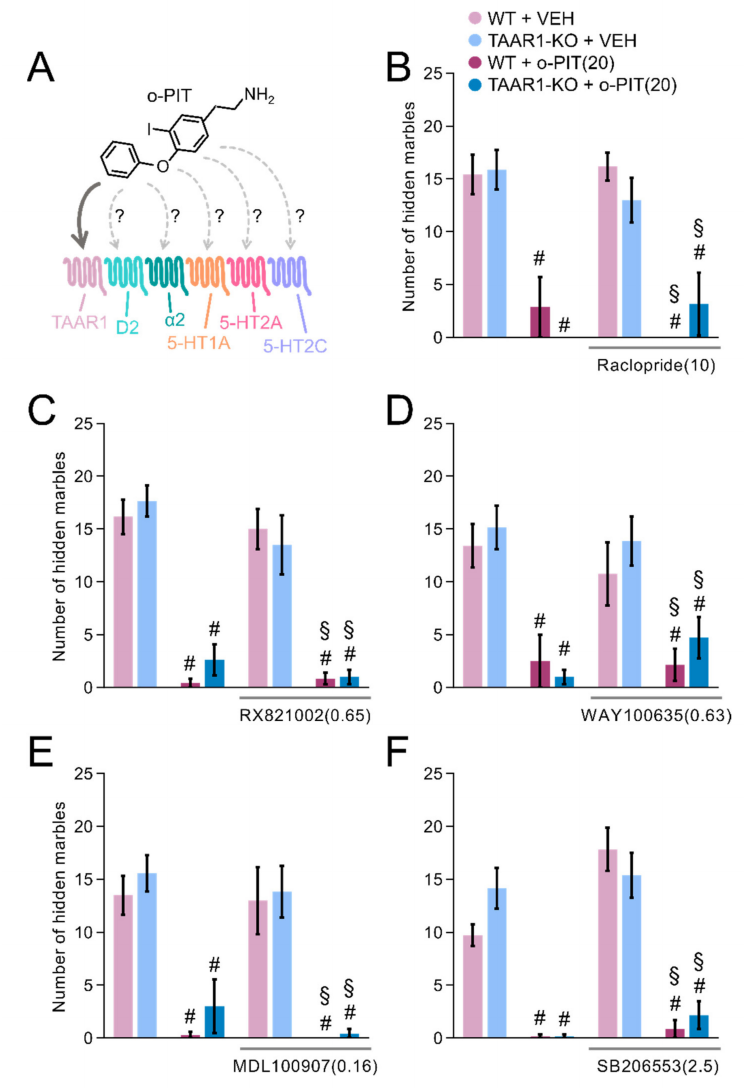
Figure 9. Influence of different monoaminergic receptors’ antagonists on o-PIT’s anticompulsive effects in TAAR1-KO and WT mice. ( A ) Schematic depiction of the possible monoaminergic receptors that may bind o-PIT. ( B – F ) Values correspond to the number of hidden marbles over 30 min after pretreatment of raclopride (10 mg/kg) (B), RX821002 (0.65 mg/kg) ( C ), WAY100635 (0.63 mg/kg) ( D ), MDL100907 (0.16 mg/kg) ( E ) or SB206553 (2.5 mg/kg) ( F ) and acute o-PIT treatment (20 mg/kg). Data represent means ± SEM. N = 8–12 per group. p < 0.05, vehicle + vehicle vs. vehicle/antagonist + o-PIT (#), antagonist + vehicle vs. antagonist + o-PIT (§). VEH: